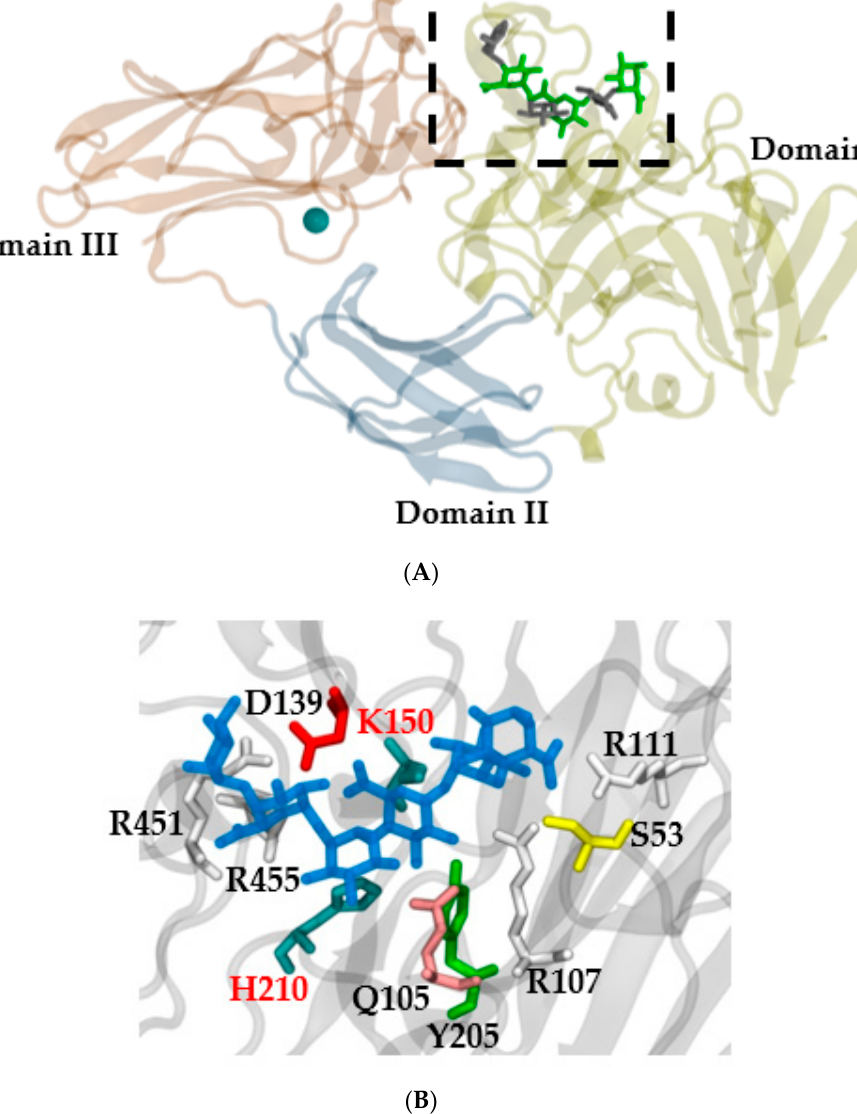
Figure 2. ( A ) Three-dimensional protein structure of RGL from A. aculeatus (PDB ID 1NKG) with a crystalized ligand from PDB ID 3NJV with the K150A mutation. Every domain is tagged, and the calcium ion is represented in VDW (green). The active site is shown in the dotted box. ( B ) Active site zoom (dotted box Figure 1A); the ligand is in blue, and the different amino acids are presented in different colors. H210 and K150 are key amino acids for enzyme activity [31]. The representation was created with Visual Molecular Dynamics [42].